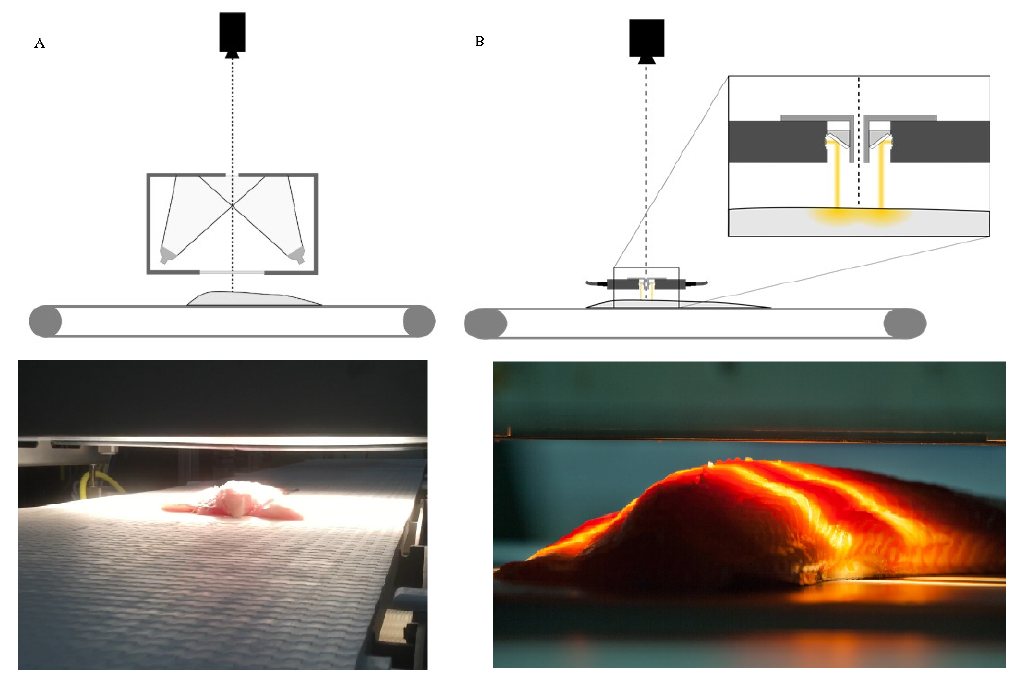
Figure 2. Hyperspectral imaging setups used to scan samples on conveyer belts with ( A ) diffuse reflectance mode and ( B ) interactance mode.